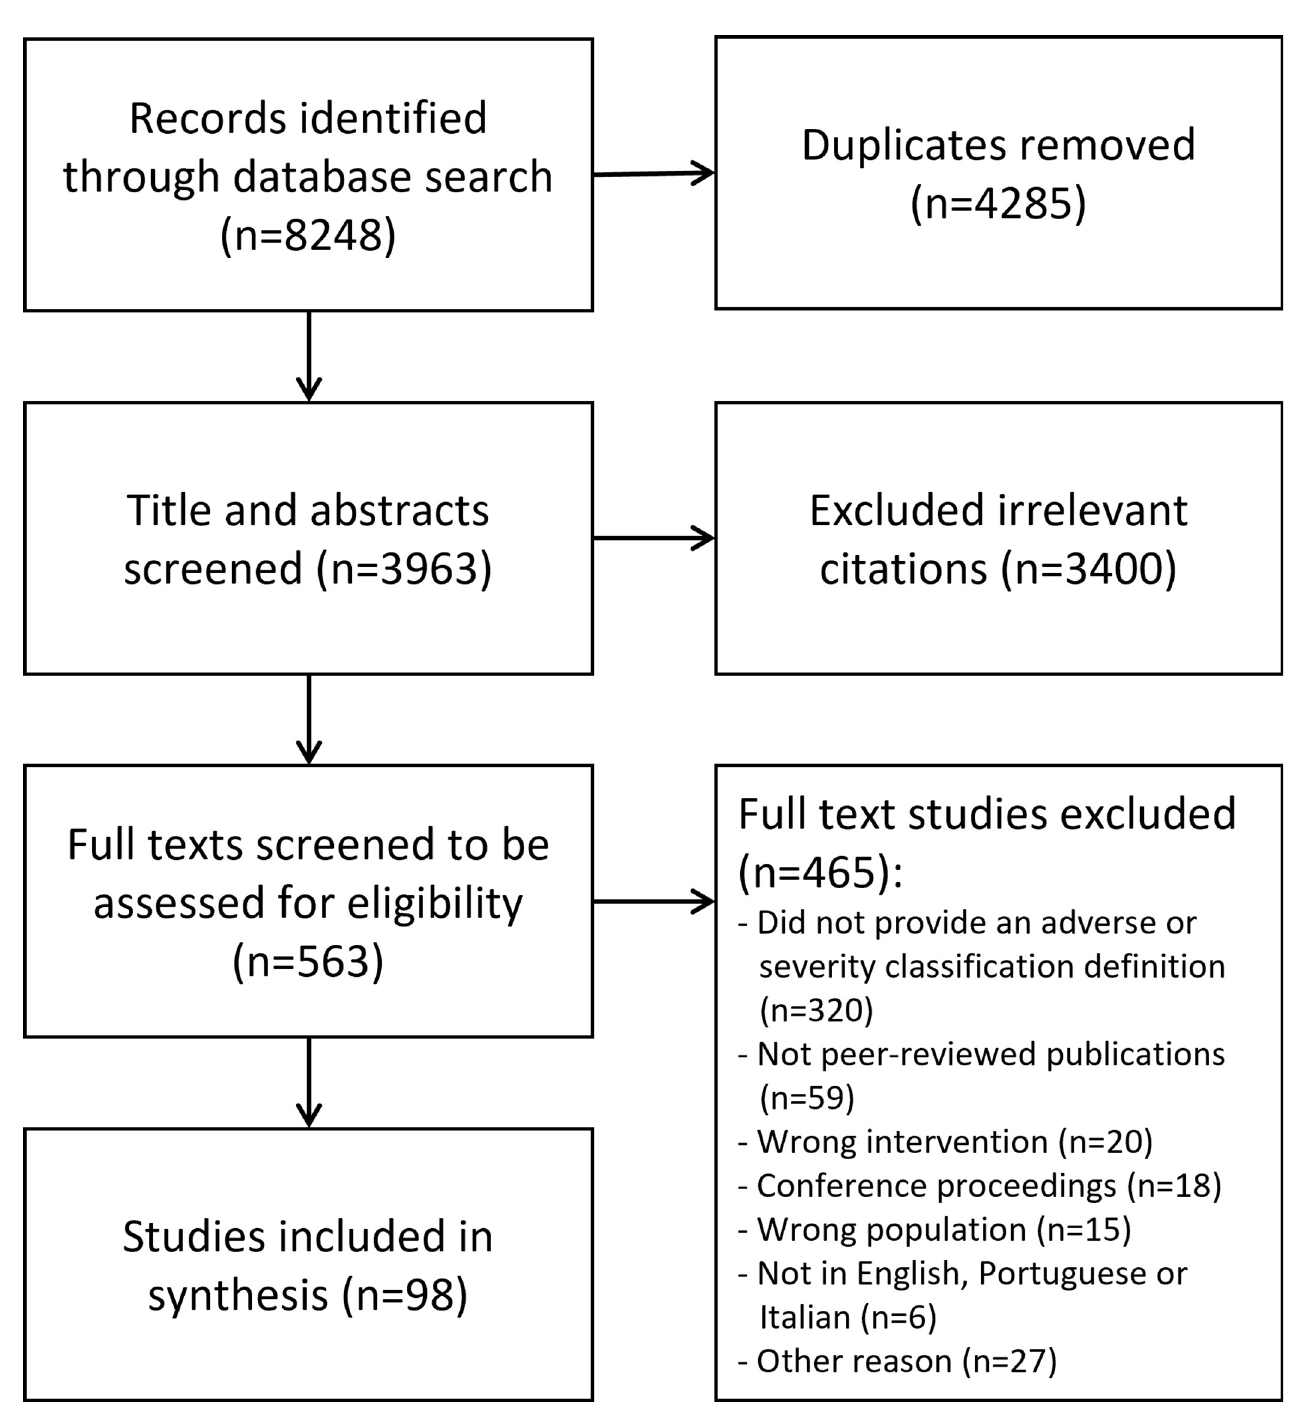
Fig 1. PRISMA Sc-R